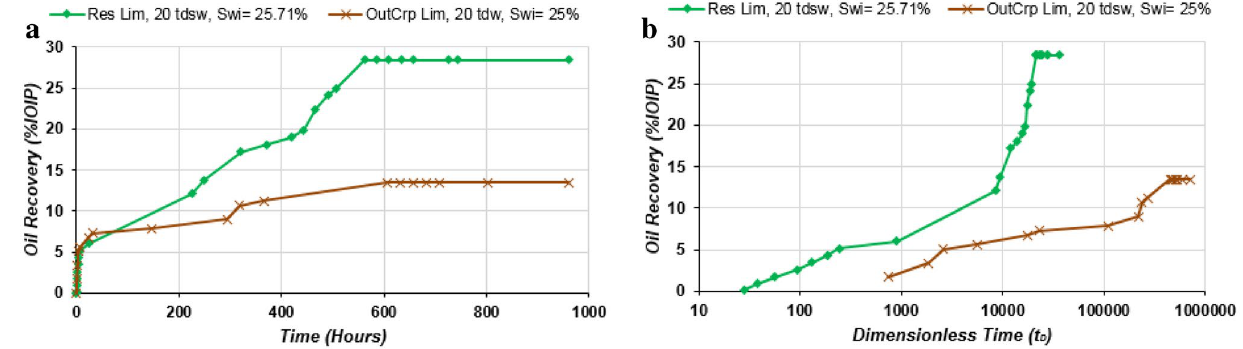
Fig. 6 Oil recovery (% IOIP) versus time resulted from spontaneous imbibition tests using outcrop carbonate cores (185 mD) and reser- voir carbonate ( k = 0.4 mD) in the presence of connate water satura-